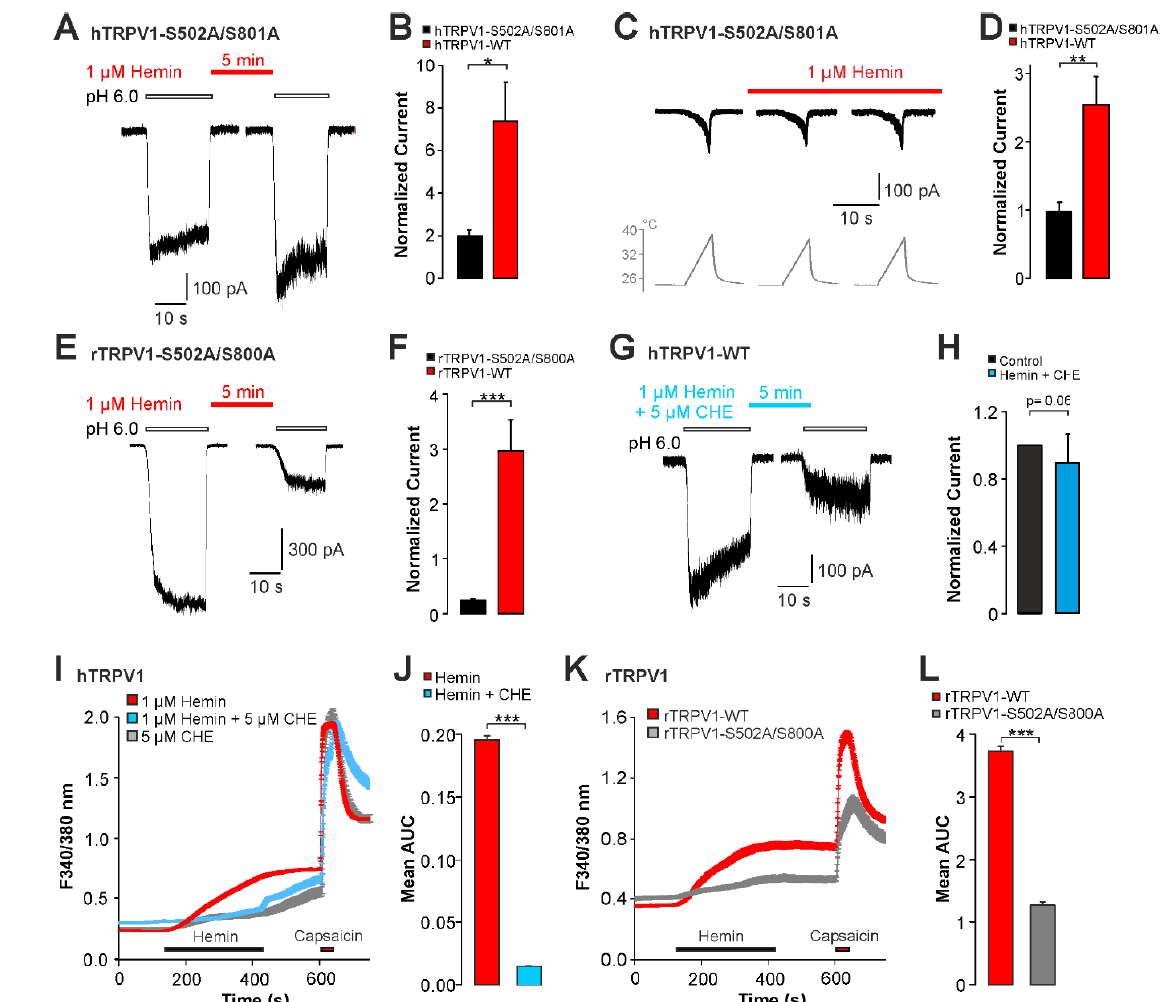
Figure 5. Hemin sensitizes TRPV1 by a PKC-dependent mechanism. ( A ) Whole-cell patch clamp recordings on cells expressing hTRPV1-S502A/S801A challenged with pH 6.0 with 1 µM hemin applied for 5 min between applications of protons. ( B ) Mean normalized peak amplitudes of inward currents evoked by pH 6.0 in ( A ). For comparison, the data obtained on hTRPV1-WT was depicted. Current amplitudes were normalized to the amplitude of the first current. ( C ) Heat-evoked inward currents in cells expressing hTRPV1-S502A/S801A. Following the first challenge with heat, cells were treated with 1 µM hemin and the depicted currents were recorded after 3 and 6 min, respectively. ( D ) Mean normalized peak amplitudes of inward currents evoked by heat in ( C ) and for hTRPV1-WT. Current amplitudes recorded after 6 min were normalized to the amplitude of the first current. ( E ) Patch clamp recordings on rTRPV1-S502A/S800A-expressing cells challenged with two consecutive applications of pH 6.0 with 1 µM hemin applied for 5 min between applications of protons. ( F ) Mean normalized peak amplitudes of inward currents evoked by pH 6.0 in ( F ) and for rTRPV1-WT. Current amplitudes were normalized to the first current. ( G ) Patch clamp recordings on hTRPV1-WT-expressing cells challenged with two consecutive applications of pH 6.0 with 1 µM hemin and 5 µM CHE applied for 5 min between applications of protons. ( H ) Mean normalized peak amplitudes of inward currents evoked by pH 6.0 in ( G ). Current amplitudes were normalized to the first current. Cells were held at − 60 mV in all patch clamp experiments. ( I ) Hemin-induced (1 µM) increase in intracellular calcium in hTRPV1-expressing cells with or without the PKC-inhibitor CHE (5 µM), or CHE applied alone. Following washout, capsaicin (1 µM) was applied for verify expression of hTRPV1. ( J ) Mean area under the curve (AUC) for hemin-induced increase in ratio described in (ANOVA F(5,3787) = 196.42, p < 0.001). ( K ) Hemin-induced (1 µM) calcium-increase in cells expressing rTRPV1-WT or rTRPV1-S502A/S800A. Following washout, capsaicin (1 µM) was applied to verify expression of rTRPV1. ( L ) Mean area under the curve (AUC) for hemin-induced increase in fluorescence ratio described in (unpaired t -test, n > 170 per group, p < 0.001). Data are shown as mean ± S.E.M. * denotes p< 0.05, ** denotes p< 0.01, *** denotes p< 0.001.